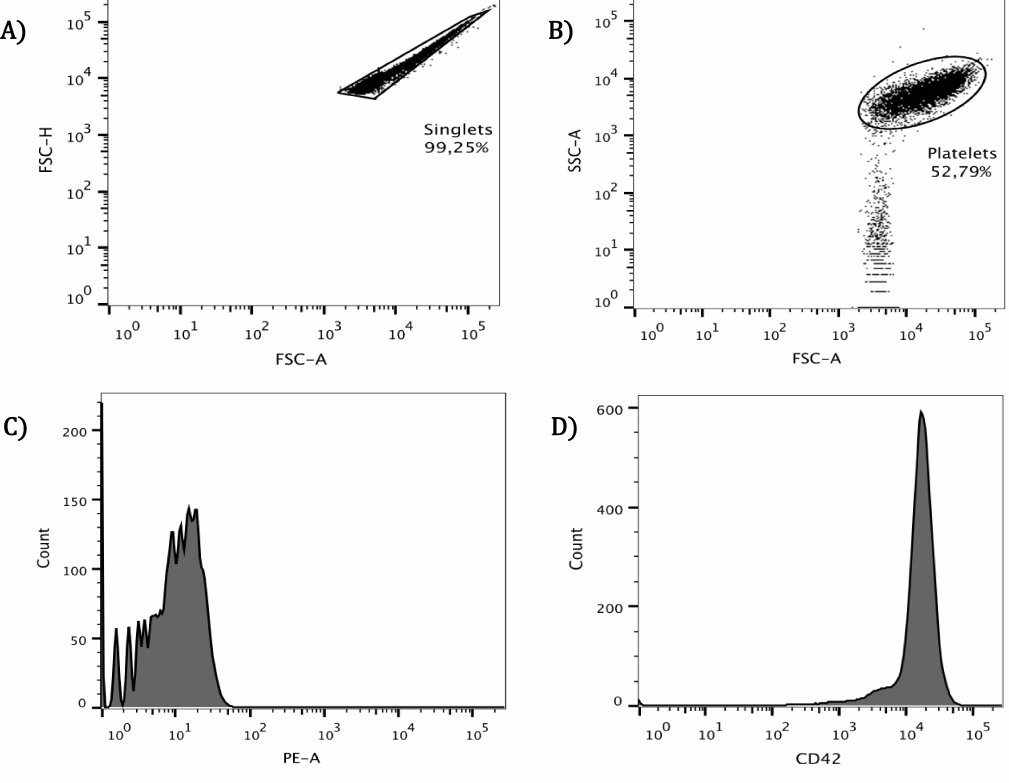
Figure 1. Platelet selection by cytometric analysis. Cells were obtained from wash platelet rich plasma (PRP) from healthy donors, carefully washed and resuspended in Tyrode’s solution. ( A ) Washed platelet suspension was acquired in the cytometer and singlets selected; these represented 98 ± 1.25%; ( B ) Platelet population was selected by size and granularity and separated from smaller size particles, which accounted for 52.79% in this particular analysis presented. Finally, to validate the selected population, the CD42b molecule was used as platelet marker, auto-fluorescence was measured ( C ); and anti-CD42-PE identified platelets, which exhibit this marker ( D